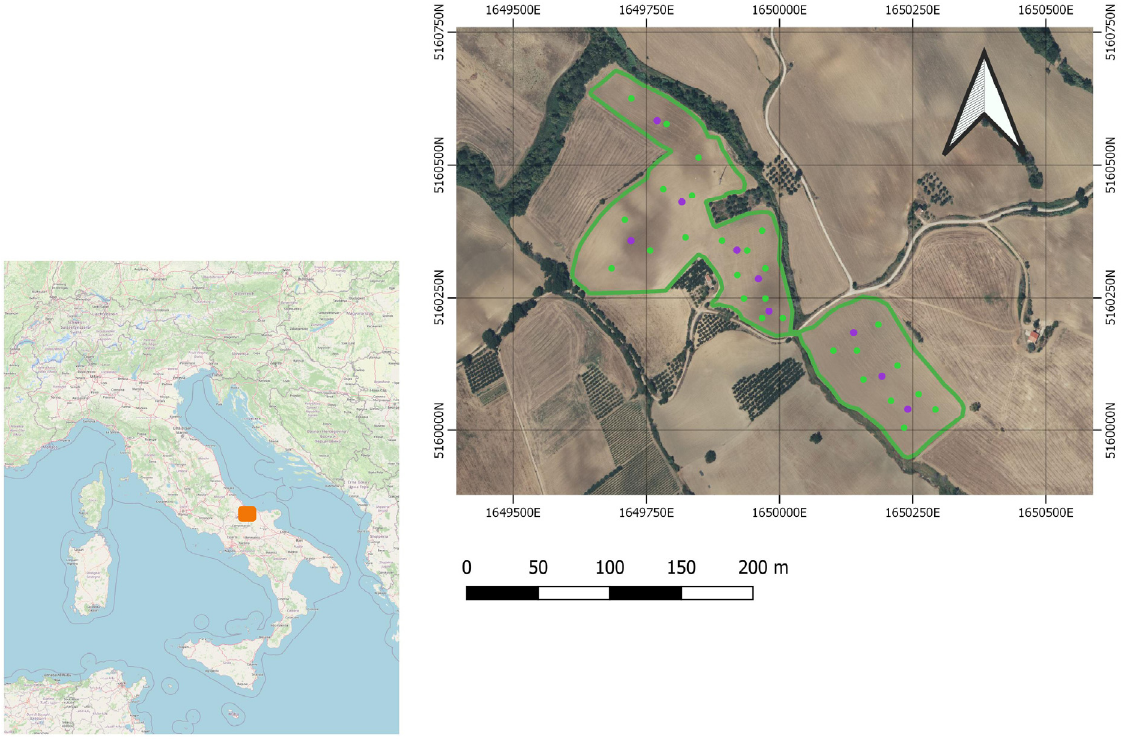
Figure 1. Left image: Study area (OSM). Right image: Experimental area boundary (green line) of durum wheat cultivars, yield and yield components samplings (green point) and yield quality samplings (purple) (RGB image).